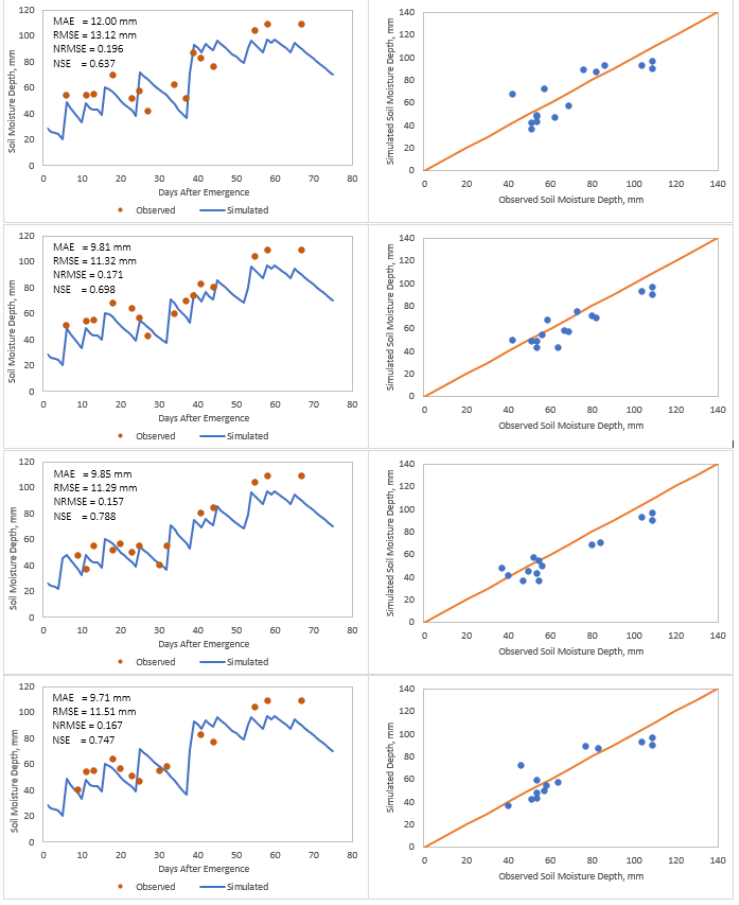
Figure 6. Simulated and observed soil moisture depths from the four plots. Table 6. Summary of the statistics obtained during model validation. Plot Mean Absolute Root Mean Normalized Root Error (mm) Square Error Mean Square